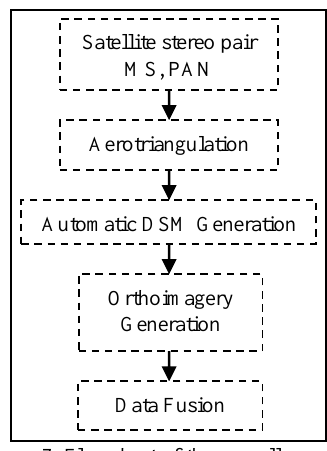
Figure 7. Flowchart of the overall process.